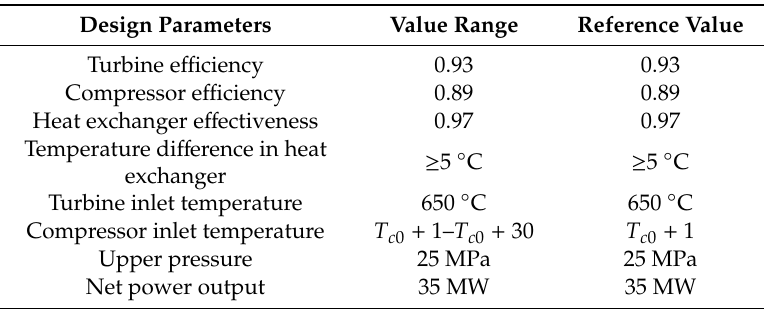
Table 3. Main parameters for the recompression power cycle with reheater.